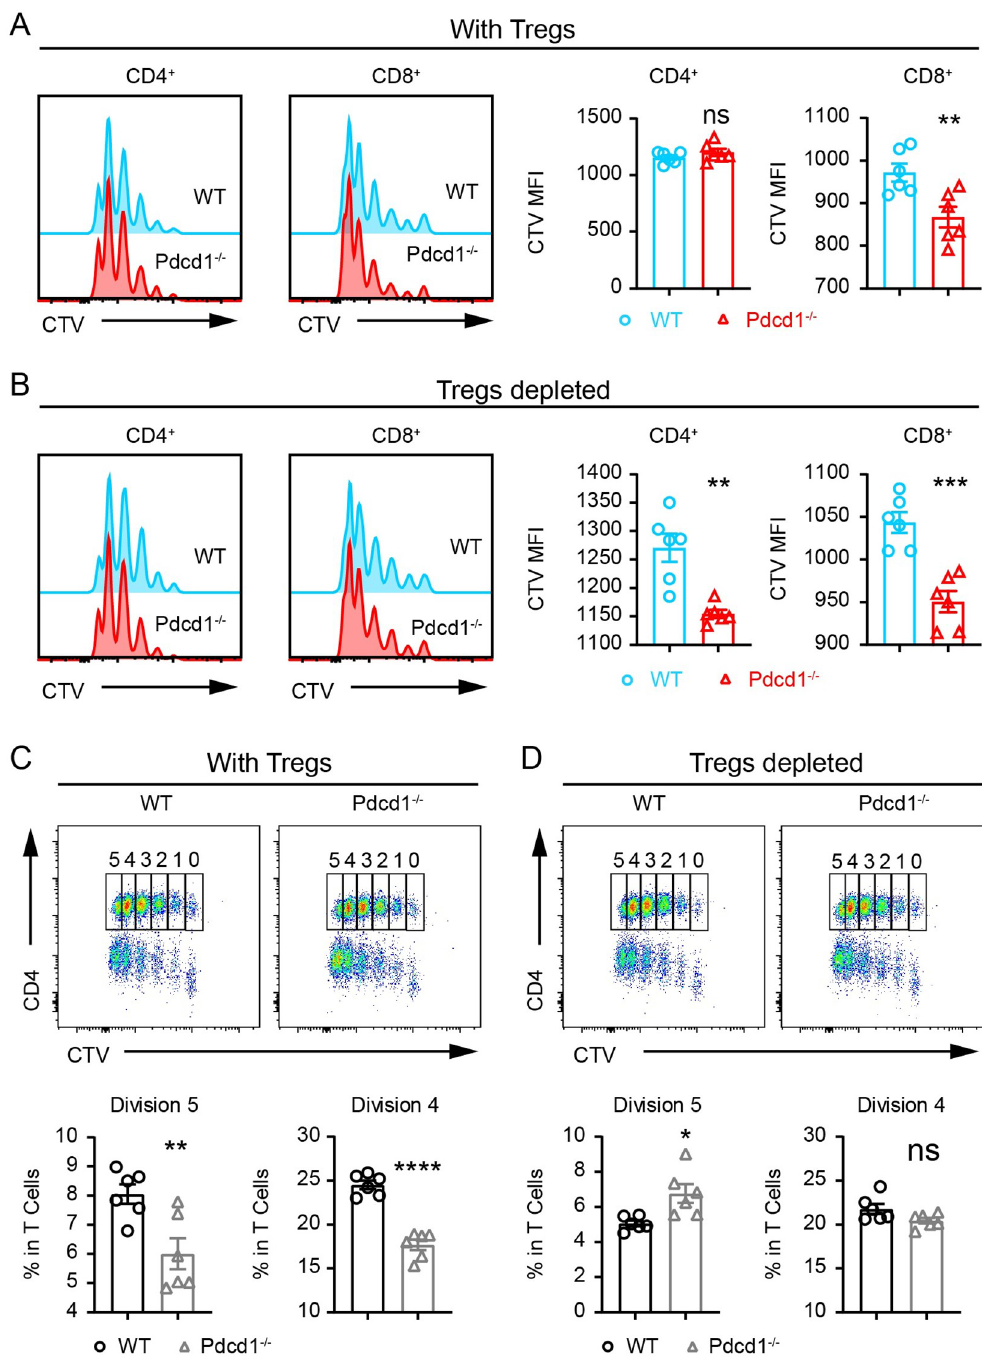
Fig 6. PD-1-deficient Tregs suppresses CD4 + T cell expansion upon TCR stimulation in vitro . (A) In T cells without Treg depletion, CTV dilution of CD4 + and CD8 + T cells purified from PD-1-deficient and WT mice was measured by FACS. Total T cells including Tregs were stimulated for 72 h with CD3 (3 μ g/mL) and CD28 (1 μ g/mL). (B) The MFI of CTV was compared between PD-1-deficient and WT CD4 + and CD8 + T cells with Treg depletion. (C) In T cells without Treg depletion, CTV dilution of CD4 + and CD8 + T cells purified from PD-1-deficient and WT mice was measured by FACS. T cells were stimulated for 72 h with CD3 (3 μ g/mL) and CD28 (1 μ g/mL). (D) The MFI of CTV was compared between PD-1-deficient and WT CD4 + and CD8 + T cells with Treg depletion. For each set of data 6 replicates were performed for statistic comparisons. Data represent the mean ± s.e.m. Statistical significance was assessed by unpaired Student’s t -test or non-parametric unpaired Mann-Whitney test and indicated by � P < 0.05, �� P < 0.01, ��� P < 0.001, ���� P < 0.0001, ns,